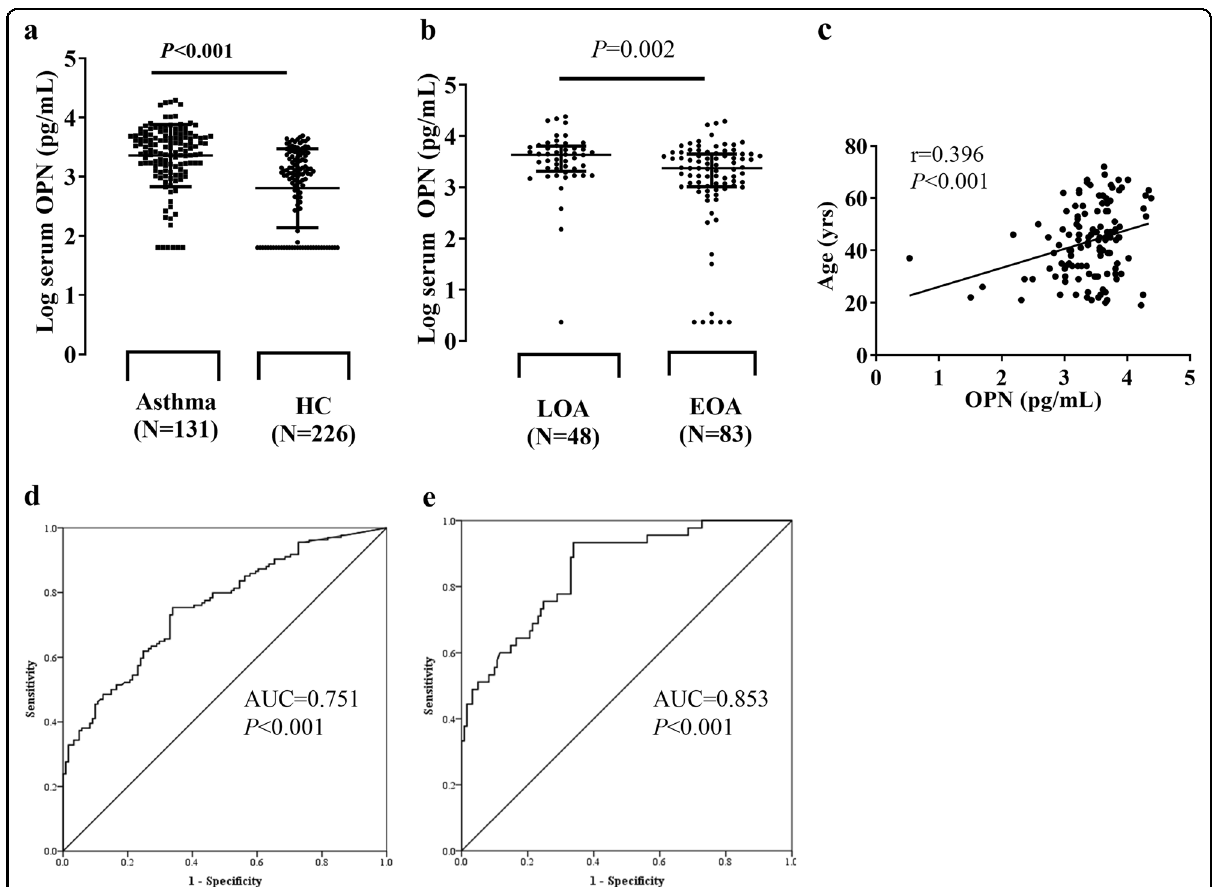
Fig. 1 Increased serum OPN levels with age in individuals with asthma. Comparison between a patients with asthma vs. HCs and b patients with LOA vs. those with EOA. P values were analyzed by the Mann – Whitney U test. ** P < 0.01, *** P < 0.001 between the groups. Data are shown as log-transformed, mean ± SEM. c Correlation between serum OPN and age, analyzed by Spearman ’ s rank correlation coef fi cient. Diagnostic values of serum OPN level in the discrimination of individuals with asthma d and individuals with LOA e from HCs. AUC area under the curve; EOA early-onset asthma, HCs healthy controls, LOA late-onset asthma, OPN osteopontin, ROC receiver operating